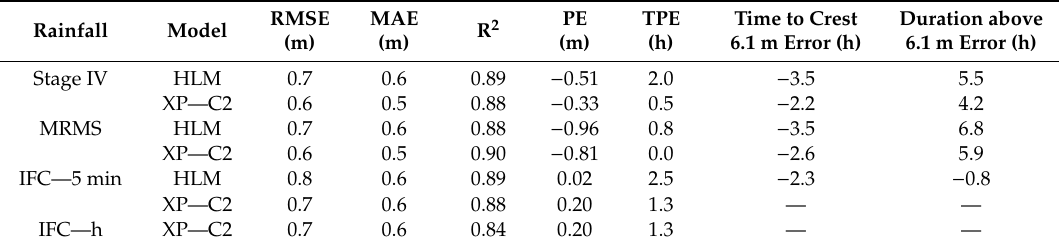
Table 3. Statistical analysis comparing the simulated stages to USGS observations for the September 2016 flood, and the time to crest and the duration above the NWS major flood stage (6.1 m) for model configurations HLM and XP—C2 using Stage IV, MRMS, and IFC (hourly and 5 min) radar rainfall